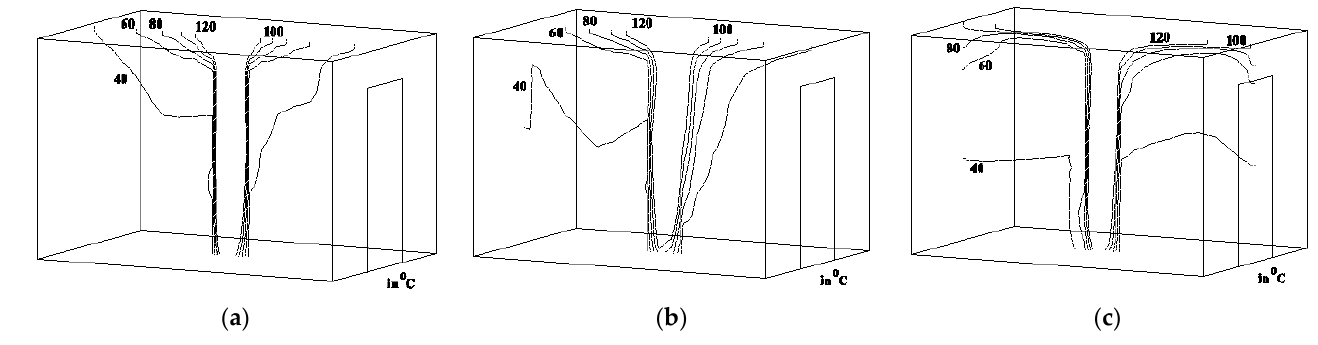
Figure 4. Predicted temperature fields using ( a ) Tu 1, ( b ) Tu 2, and ( c ) Tu 3. The mass source error is defined